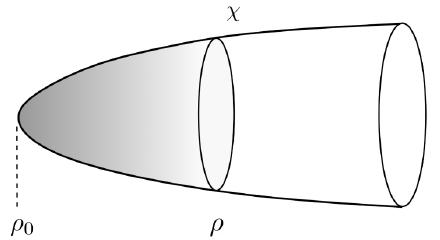
Figure 9 . A Euclidean string worldsheet wrapping the cigar gives rise to the expectation value of the winding mode at position ρ , χ ( ρ ) ∝ e − 1 (area) ∝ e − ( ρ − ρ 0 ) R/α 0 in Schwarzschild coordinates, 2 πα 0 for ρ (cid:29) ρ , and R (cid:29) l 0 s